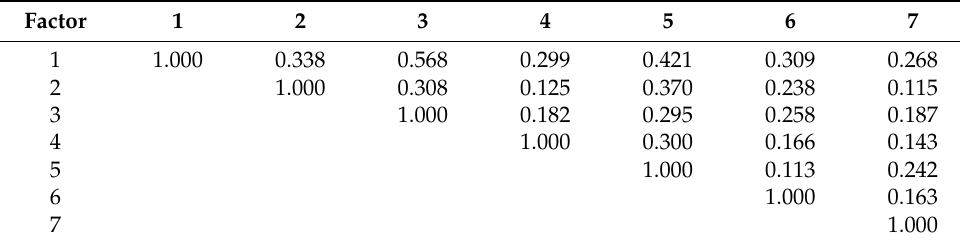
Table 3. Correlation matrix between